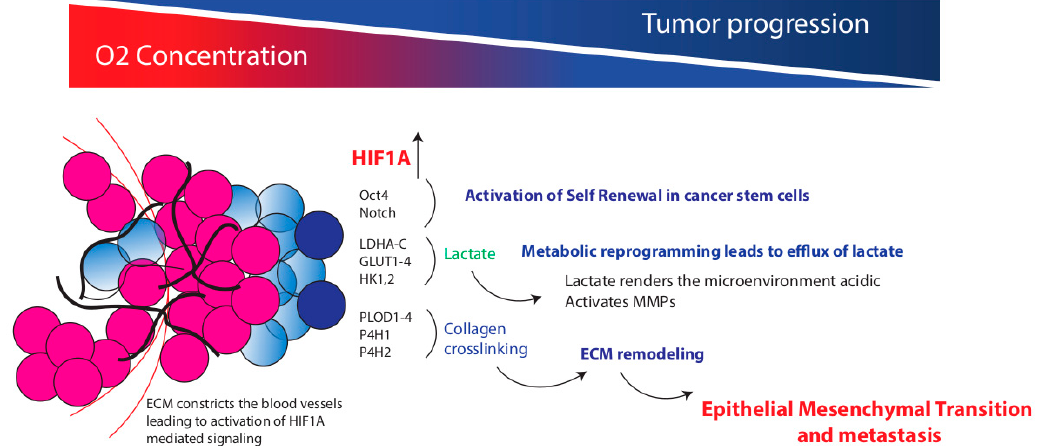
Figure 2. Regulation of cancer stem cell (CSC) metabolism by ECM. Deposition of ECM during tumor progression leads to extensive hypoxia within the tumors. This activates HIF1A-mediated signaling in the tumor cells, resulting in activation of self-renewal pathways, metabolic reprogramming and ECM remodeling, eventually leading to metastasis.